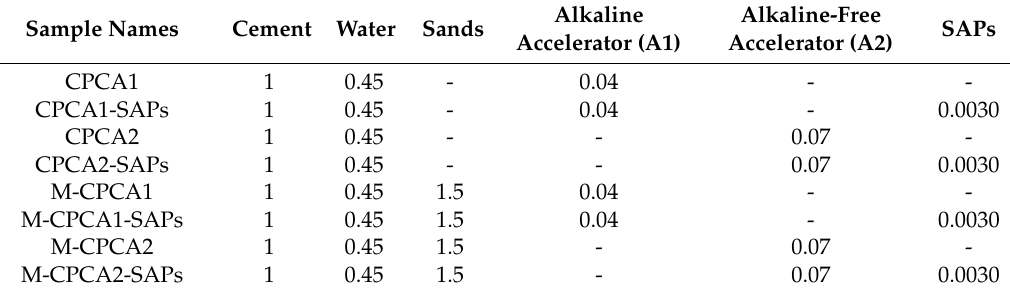
Table 2. Mix design of the cement paste and mortar in this